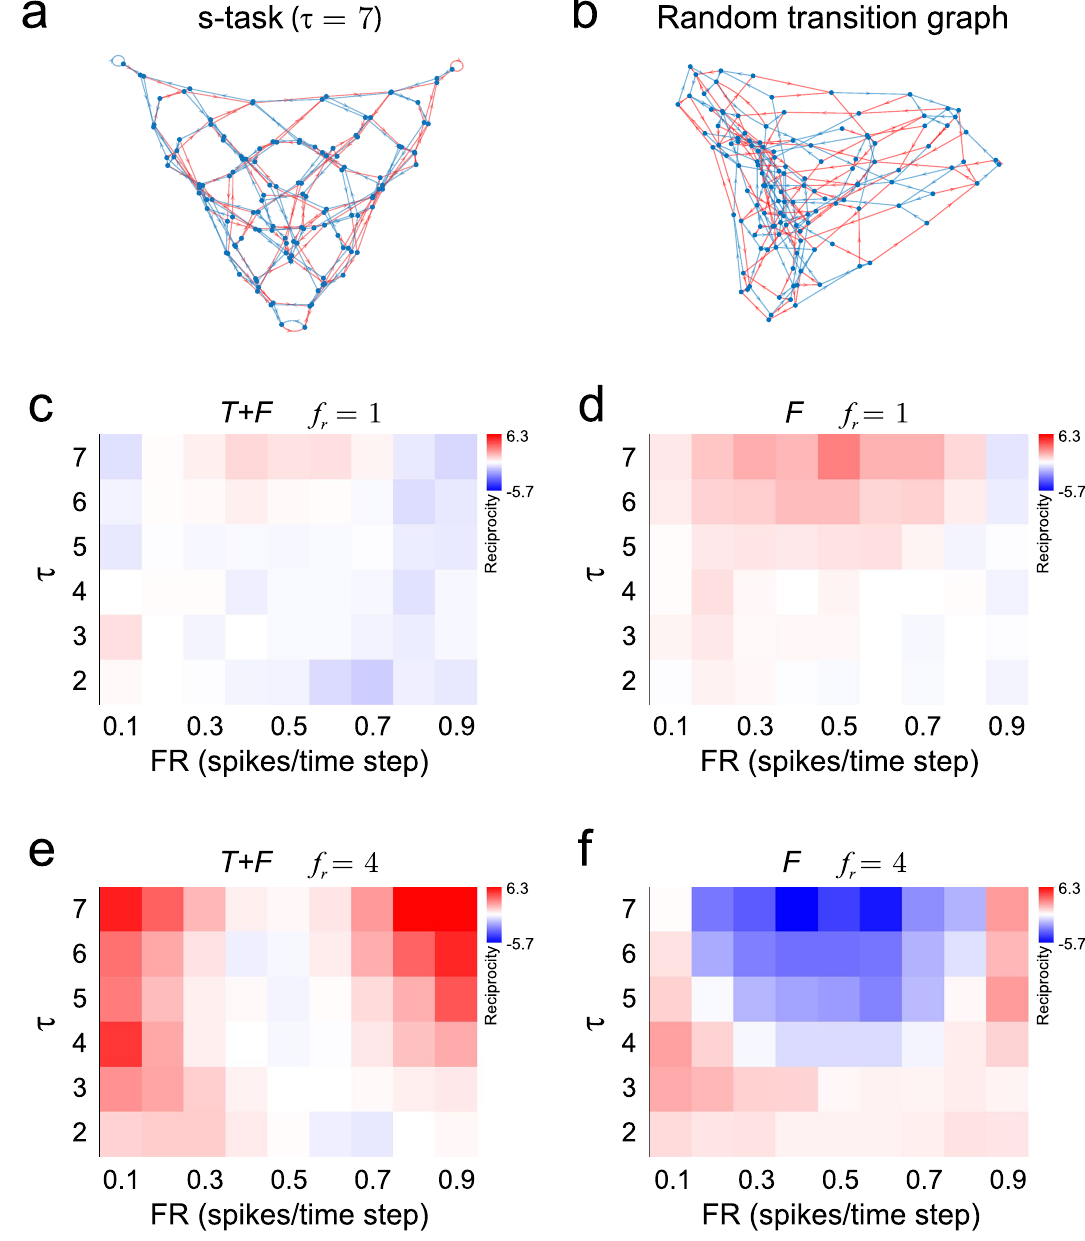
Figure 5. Reciprocity as a function of τ , FR and the type of transition graph. ( a ) Transition graph for solving the s-task with τ = 7 . Blue and red lines represent transitions gated by s 1 and s 2 , respectively. ( b ) Random transition graph. Nodes (network states) may receive different number of incoming connections. There are 24 nodes that are gated by both stimuli. ( c ) Reciprocity for T + F networks, with f r = 1 , as a function of τ and target FR. Reciprocity changes from slightly negative to slightly positive as τ increases. For τ = 7 , reciprocity is maximized around target FR = 0.5 spikes/time step and decreases for lower and higher values of target FR. ( d ) F networks with f r = 1 shows increasing positive reciprocity as τ increases, maximized at target FR = 0.5 spikes/time step. ( e ) When the number of neurons is higher ( f r = 4 ), T + F networks show positive reciprocity that is minimal around target FR = 0.5, and increases towards higher and lower target FR, reaching the highest reciprocity values among all networks screened. ( f ) Reciprocity of F networks turns increasingly negative as τ increases, reaching the lowest reciprocity among all networks screened, around target FR = 0.5 spikes/time step. For all panels, 30 networks were constructed for each τ and target FR combination. Normalized means (mean/SD) are shown. Positive and negative reciprocity values were mapped separately to colours red and blue, respectively. Red tones go from 0 reciprocity (white) to maximal positive reciprocity (pure red). Blue tones go from 0 reciprocity (white) to maximal (in absolute value) negative reciprocity (pure blue). All random graphs were constructed with f bc = 0.5 . Graphs were plotted with the Force-directed